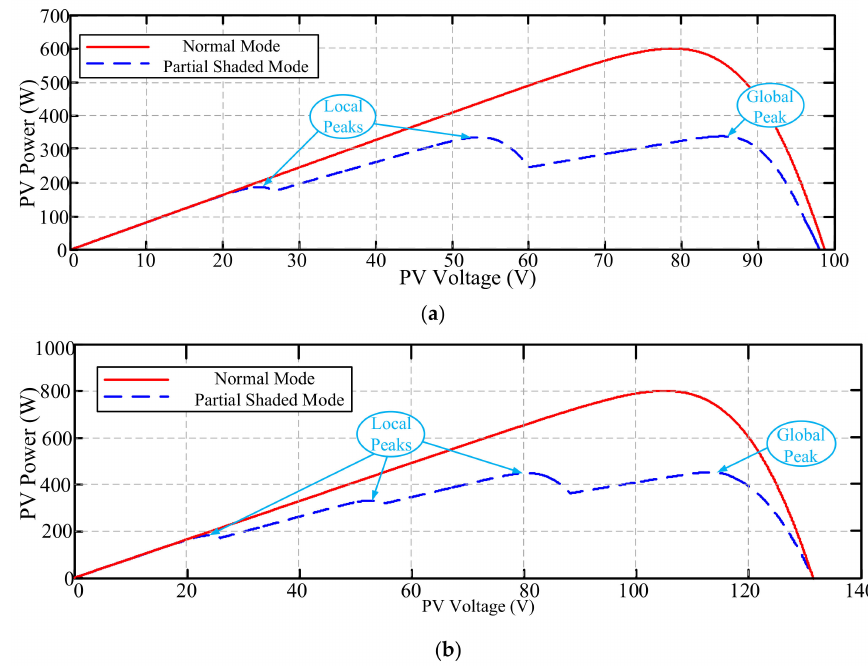
Figure 10. PV power curves for ( a ) three modules ( b ) four modules at normal and partial shad- ing conditions.